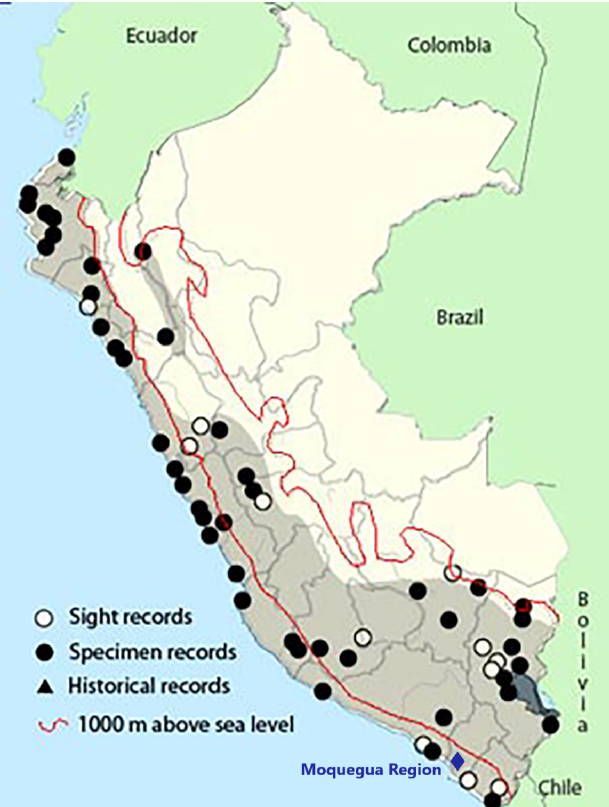
Figure 8. Map of Burrowing Owl distribution in Peru [69], and study region location in southern Peru.